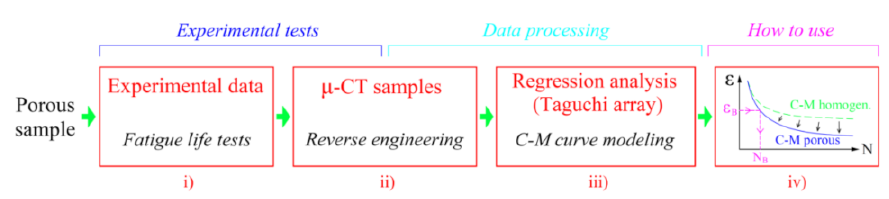
Figure 1. Flowchart of a procedure for estimation the fatigue life of a porous